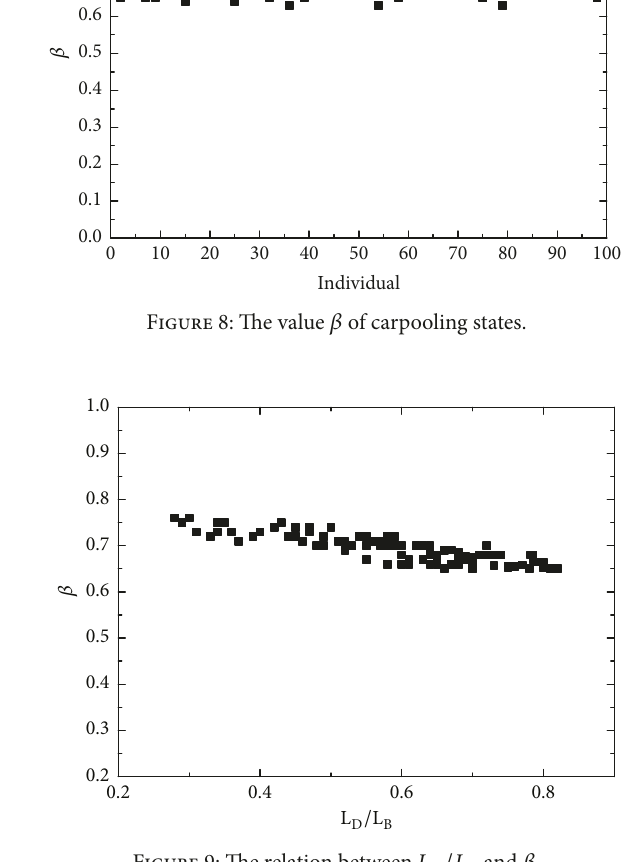
Figure 9: The relation between 𝐿 𝐷 /𝐿 𝐵 and 𝛽